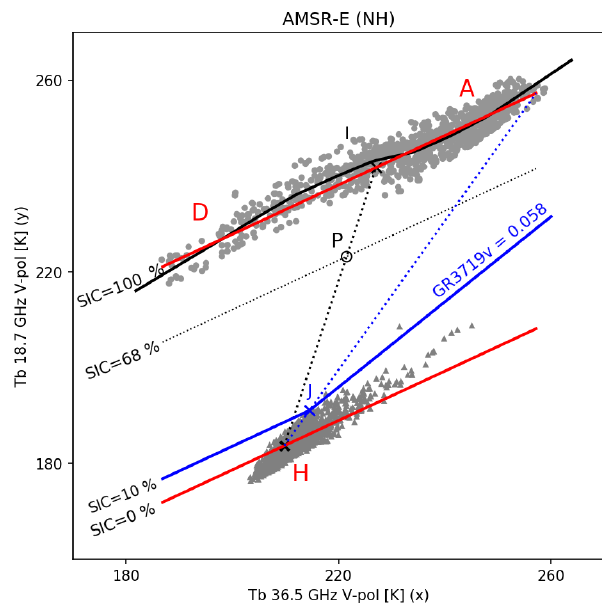
Figure 3. Illustration of the bootstrap frequency mode (BFM, Sect. 3.2) and open-water filter (OWF, Sect. 3.4.2) algorithms in a 36 . 5 V ( x axis) and 18.7GHz ( y axis) T B space of AMSR-E (Winter NH conditions). The grey symbols are actual AMSR-E T B measure- ments over SIC = 0% (triangles) and SIC = 100% (disks) condi- tions, from Pedersen et al. (2018). The SIC = 100% measurements fall generally along a line (the consolidated ice line), while the mean open-water signature is point H. An example measurement P (black circle) falling on the SIC = 68% isoline illustrates the functioning of BFM. The blue solid and dotted lines illustrate the tuning and functioning of the OWF (as described in Sect. 3.4.2). The black solid curve fitting SIC = 100% conditions illustrates the ice curve correction (as described in Sect.